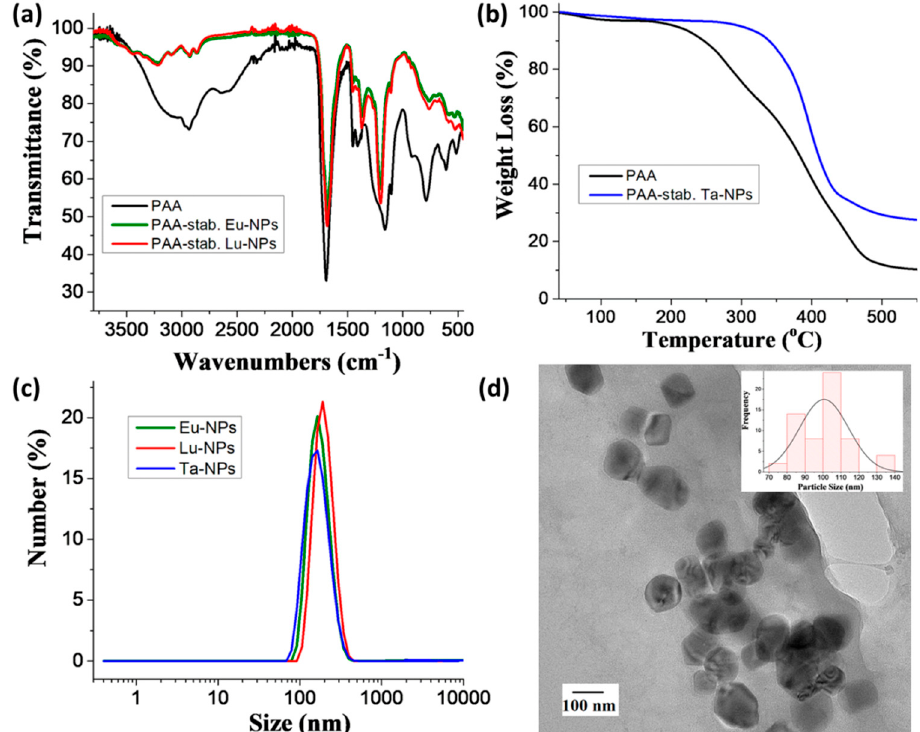
Figure 2. ( a ) FTIR, ( b ) TGA, and ( c ) dynamic light scattering (DLS) spectra of PAA-stabilized Lu-NPhs (red line), Eu-NPhs (green line), and Ta-NPhs (blue line) along with PAA (black line). The number-average diameter was 183.3 ± 27.7 nm, 184.5 ± 26.2 nm, and 166.6 ± 5.0 nm for PAA-stabilized Lu-, Eu-, and Ta-NPhs respectively; ( d ) TEM image of PAA-stabilized Eu-NPhs with a diameter of 101.9 ± 15.6 nm.